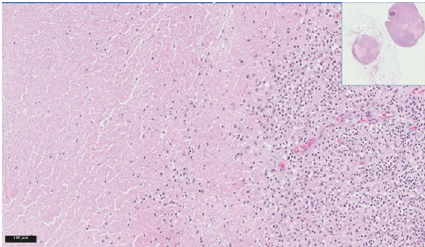
Figure 5: 2 lymph nodes with confluent necrotizing granulomatous inflammation as visualized at 1x (inset) and